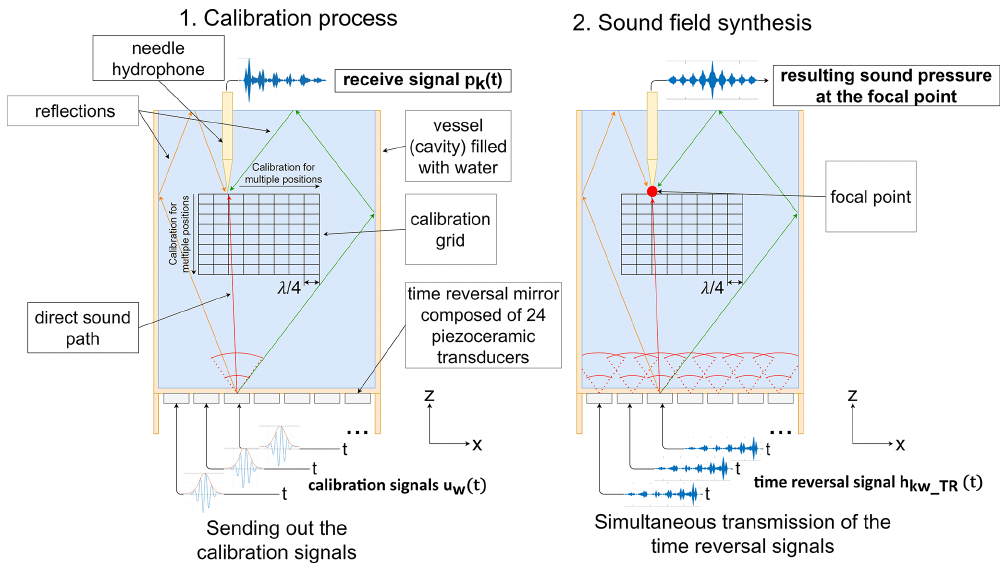
Figure 1. Principle of 3D sound field focusing in closed vessels using time reversal technique.